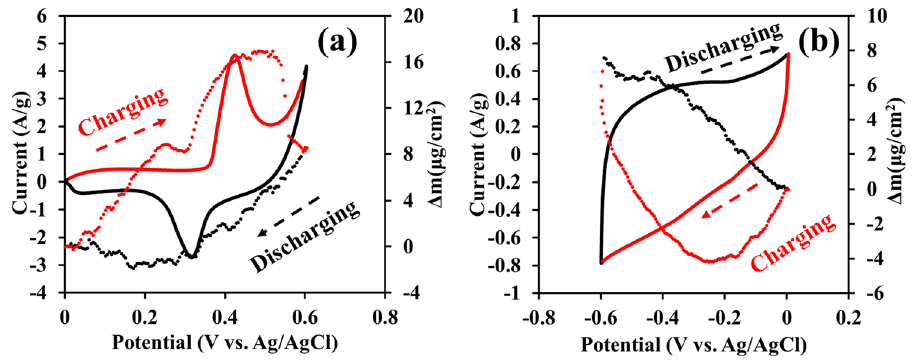
Figure 2. EQCM responses and CVs of ( a ) α -Ni(OH) 2 -N-rGO ae and ( b ) N-rGO ae at 10 mVs − 1 . Note, dash lines present the related mass changes of the electrodes during